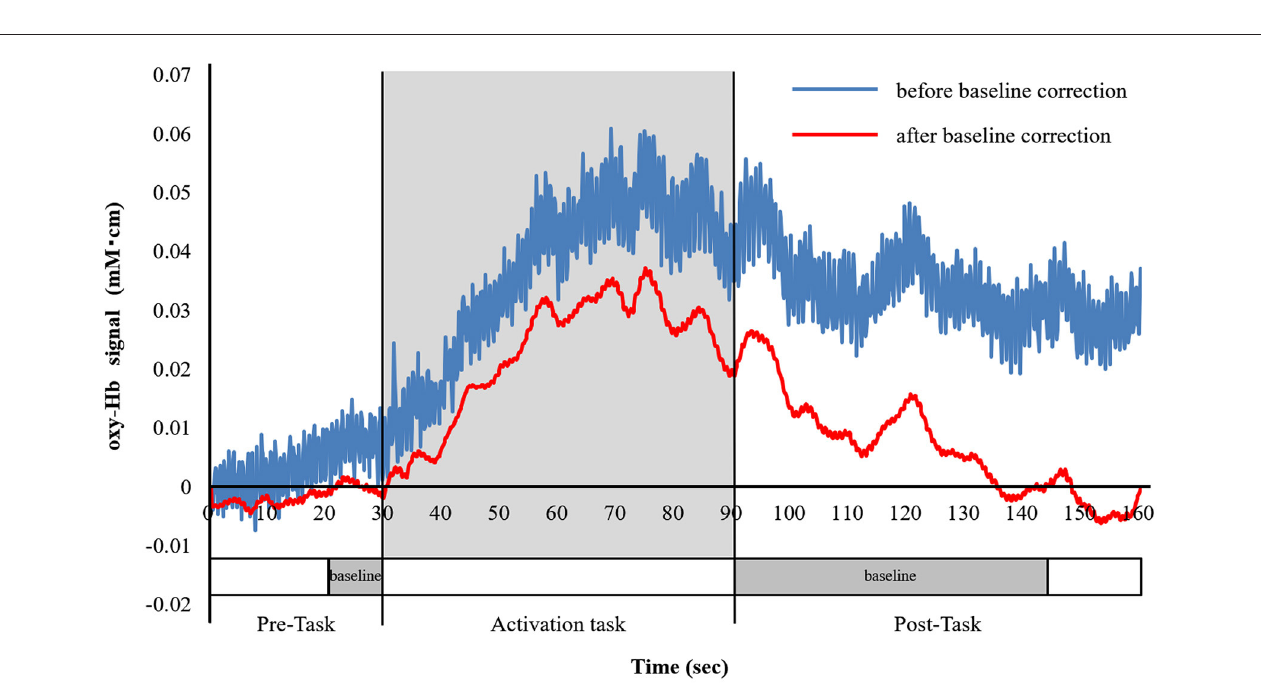
FIGURE 3 | Analysis of the fNIRS data. The blue line indicates oxygenated hemoglobin (oxy-Hb) before the baseline correction, and the red line indicates oxy-Hb after the baseline correction. Baseline correction was performed in the last 10-s of the pre-task period and the first 55-s of the post-task period, which is shown by the dotted line on the time axis. Baseline correction was performed using the moving average method. We, then, averaged the oxy-Hb data of 19 channels and calculated the integral value of the task